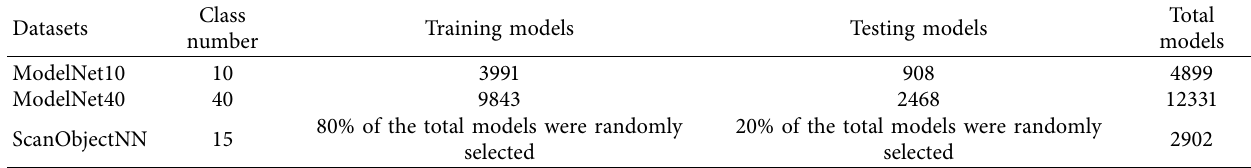
Table 1: Distribution of training and test